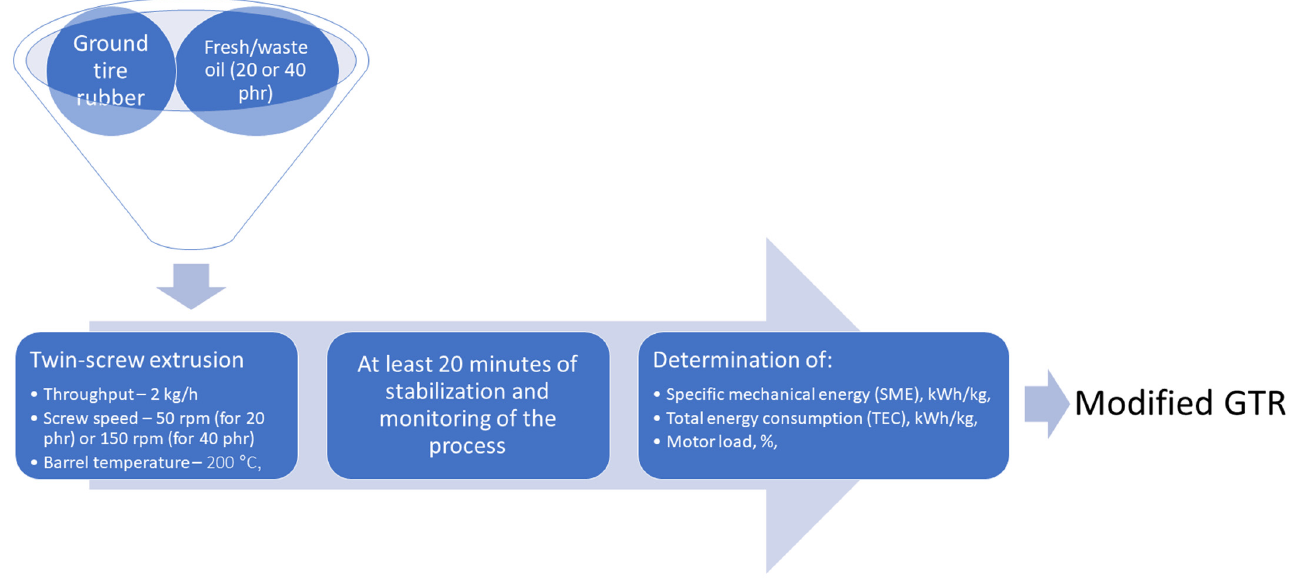
Figure 1. The scheme of GTR modifications performed in the twin-screw extruder.